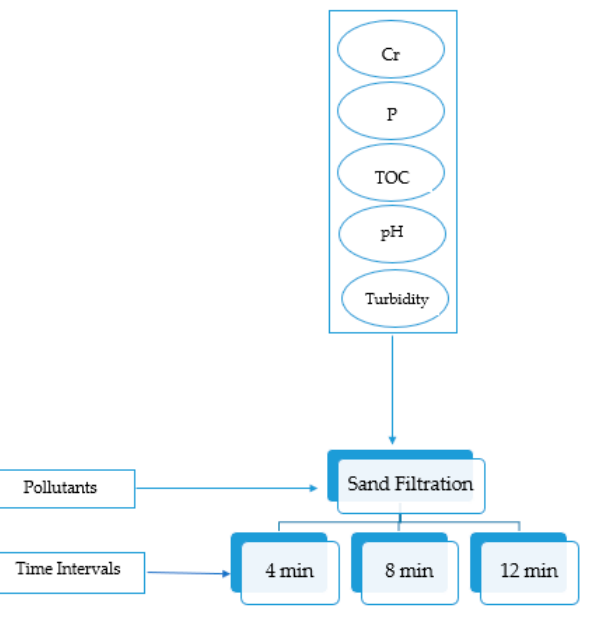
Figure 4. Sand filtration experimental plan.